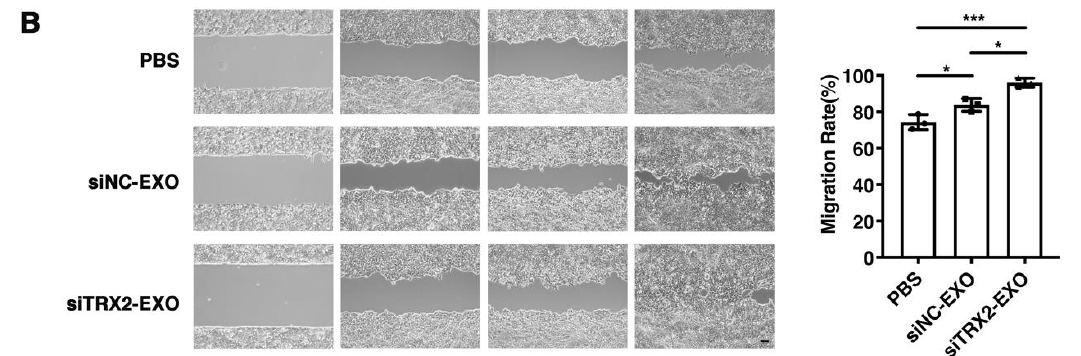
Figure 7. Effect of exosomes on HCT116 cell migration. ( A ) HCT116 cells were transfected with pcDNA3.1+ or FLAG-TRX2, and exosomes were purified. Then, 2 × 10 5 particles of exosomes were added to HCT116 cells cultured in exosome-free media. Cell migration was measured by scratch tests. ( B ) HCT116 cells were transfected with siNC or siTRX2, and exosomes were purified. Then, 2 × 10 5 particles of exosomes were added to HCT116 cells cultured in exosome-free media. Cell migration was measured by scratch tests. The experiments were performed for three biological replicates. The scale bar = 50 µ m. The error bars represent means ± SD. EXO, exosome; * p < 0.05, *** p < 0.001, and **** p < 0.0001 using one-way ANOVA with Š í d á k’s multiple comparisons